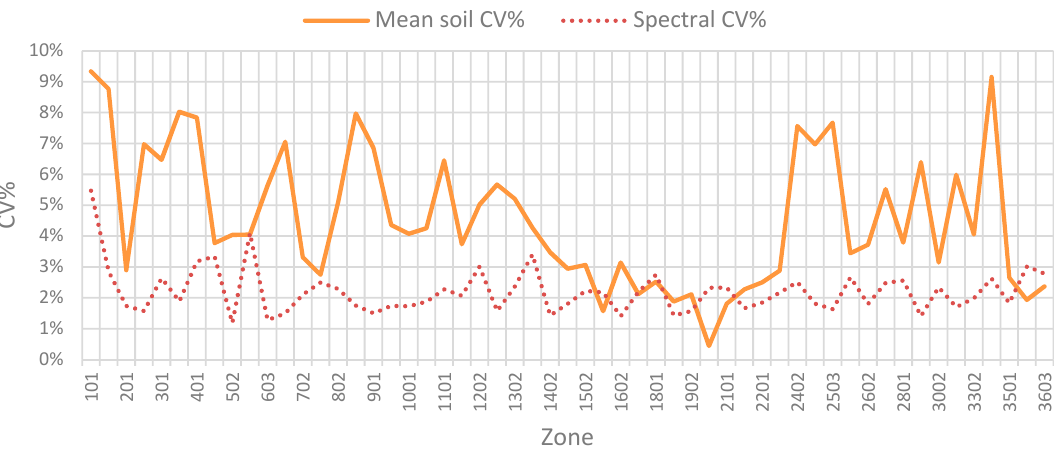
Figure 9. Plot of between- and within-zone variation for the analyzed soil properties.